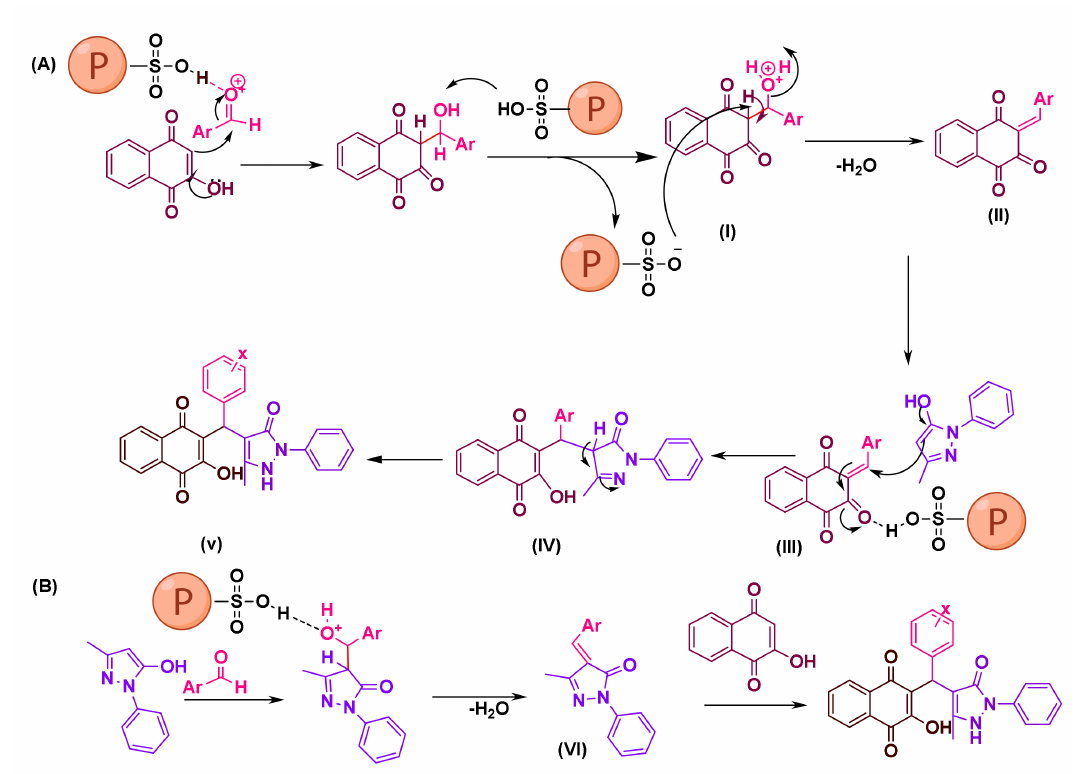
Figure 5. Suggested mechanism for the synthesis of benzyl pyrazolyl naphthoquinone catalyzed by MSMF. ℗ represents polymer-based catalyst. First possible mechanism ( A ) and second possible mechanism ( B ).